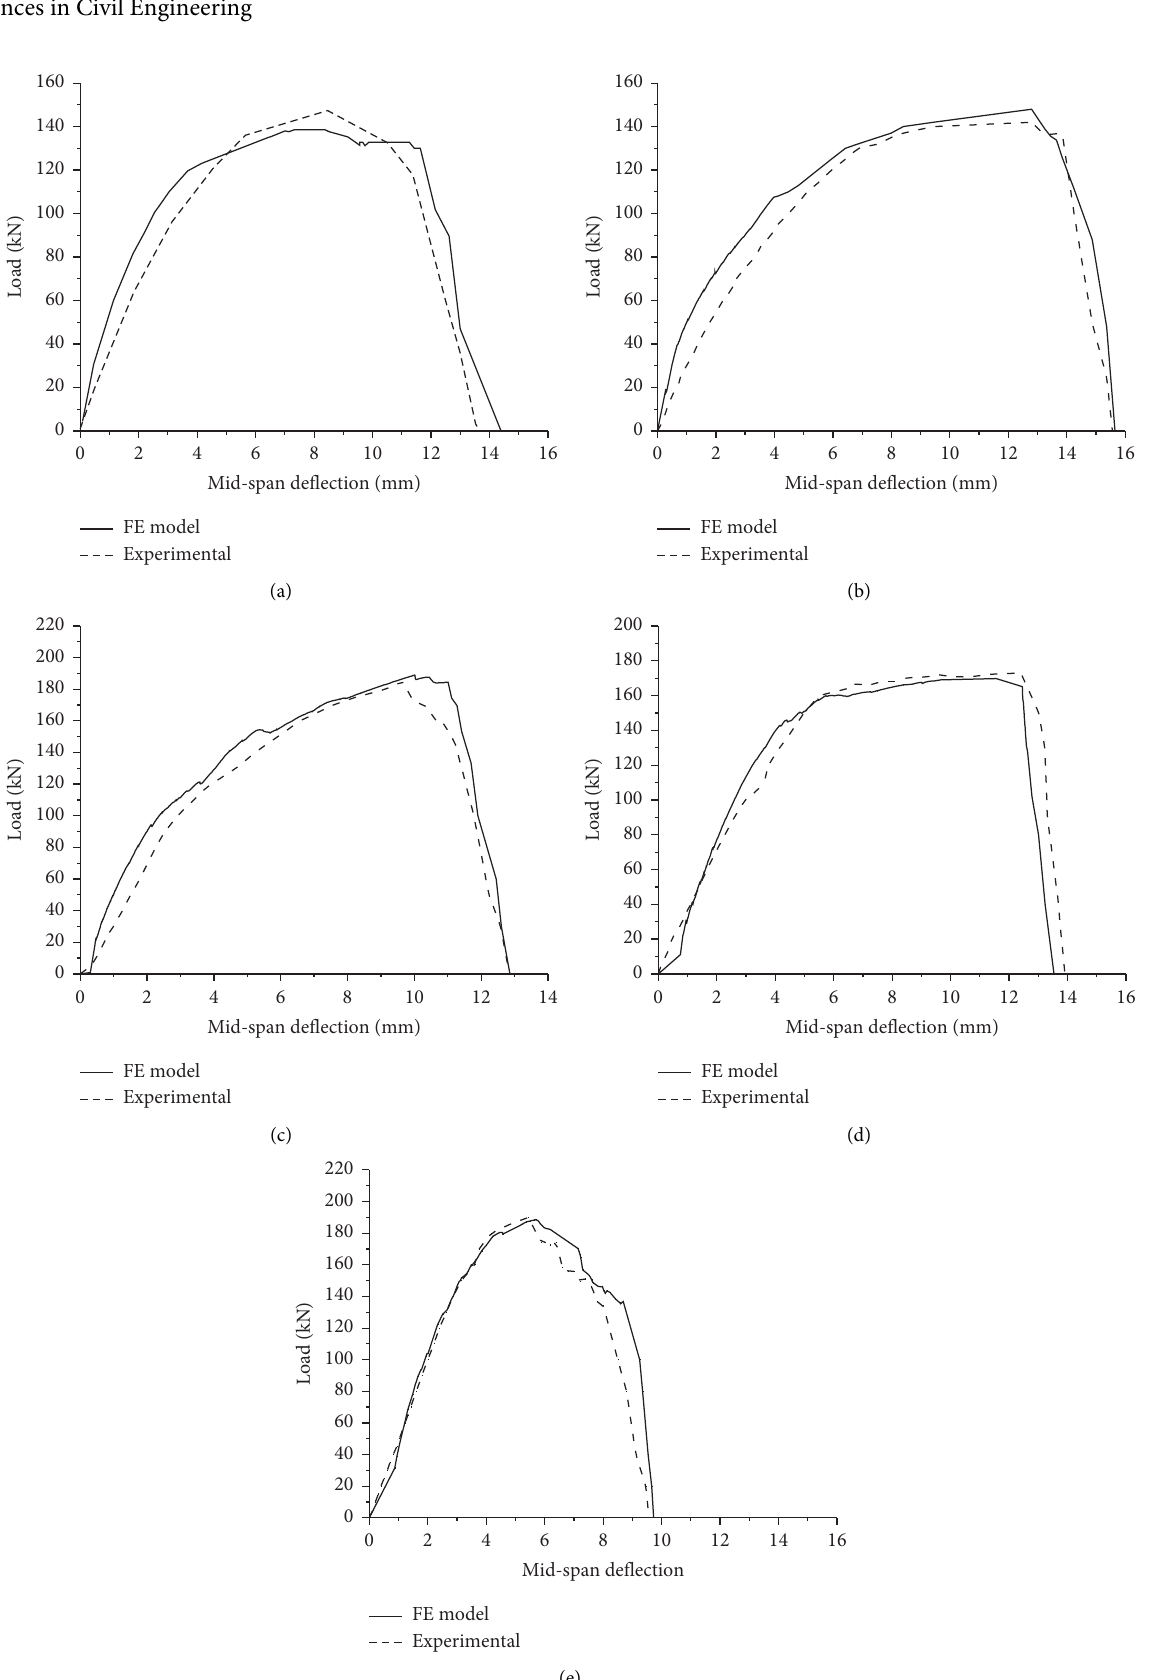
Figure 13: Comparison of the load-deflection curve between the test and FE model: (a) beam C0C30, (b) beam C10C30, (c) beam S10C30, (d) beam U10C30, and (e) beam